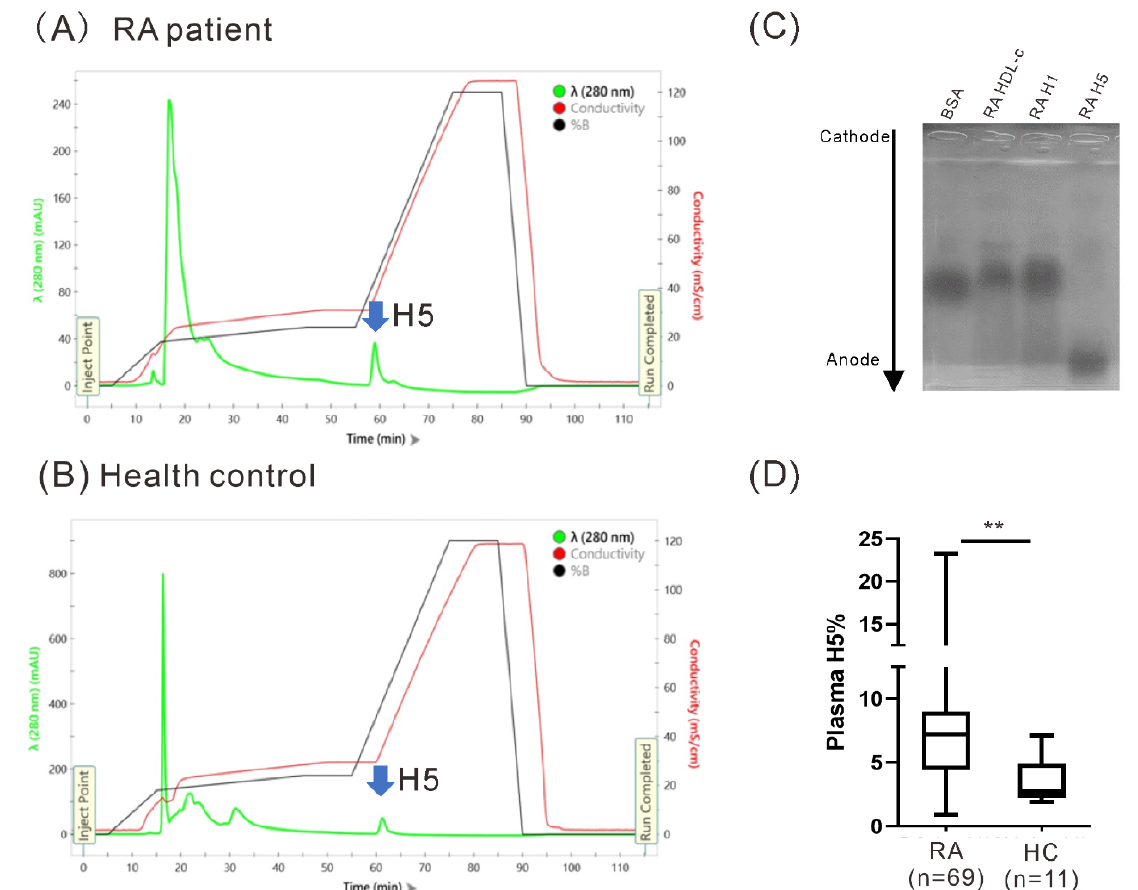
Figure 1. Analysis of HDL-c subfractions H5 from RA patients and HC individuals. According to electronegativity, HDL-c subfractions H1 and H5 were eluted at the indicated time points according to electronegativity using anion-exchange fast-protein liquid chromatography. Chromatograms are shown for ( A ) a RA patient and ( B ) healthy control. ( C ) HDL-c subfractions were subjected to agarose gel electrophoresis at 50 V for 2.4 h (BSA was used as a reference). ( D ) Comparisons of plasma H5% between RA patients and healthy controls. The data are presented as box-plot diagrams, in which the box encompasses the 25th percentile (lower bar) to the 75th percentile (upper bar). The horizontal line within the box indicates the median value for each group. BSA: Bovine serum albumin; HC: Healthy control; HDL-c: High-density lipoprotein cholesterol; RA: Rheumatoid arthritis. ** p < 0.005 vs. HC, determined using the nonparametric Mann–Whitney U